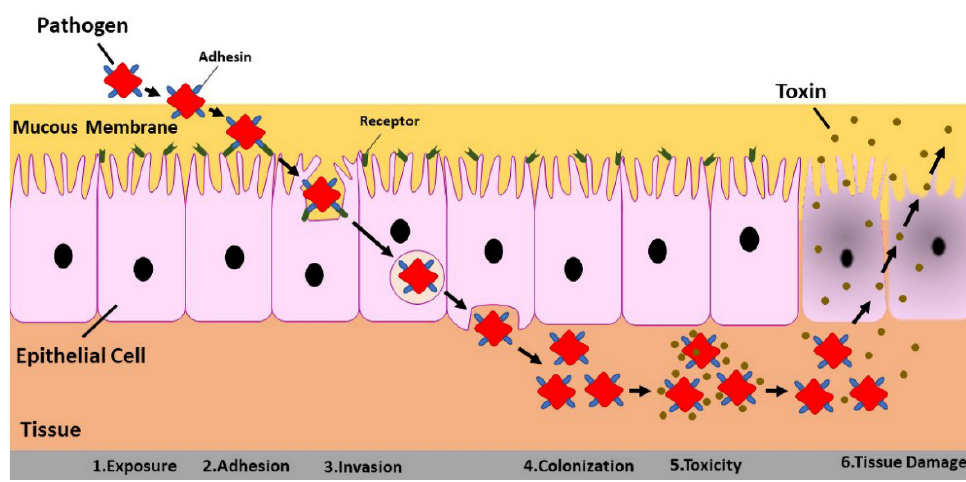
Figure 3. Mechanisms of microbial infections.